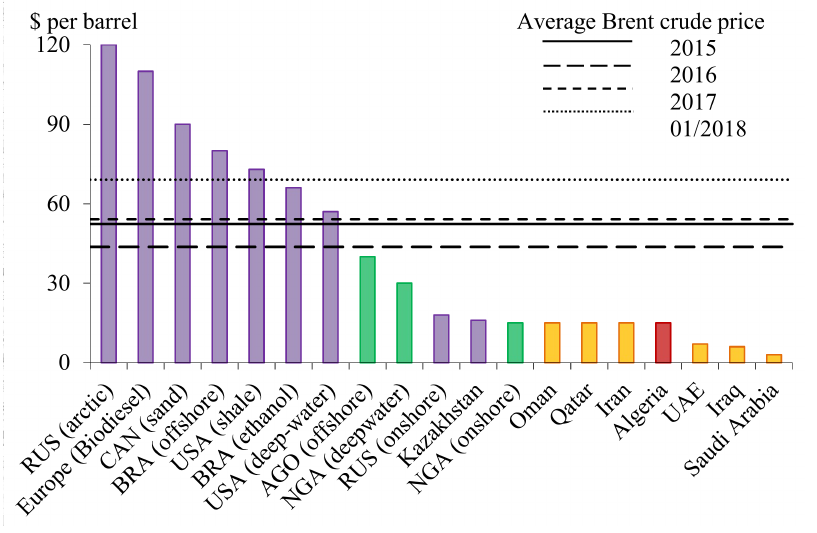
Figure 2. Marginal production costs (2014) vs. Brent price in $ (U.S. dollars, USD). Data source: [1,18]. Abbreviations: Russia (RUS), Canada (CAN), Brazil (BRA), Angola (AGO), Nigeria (NGA) and United Arab Emirates